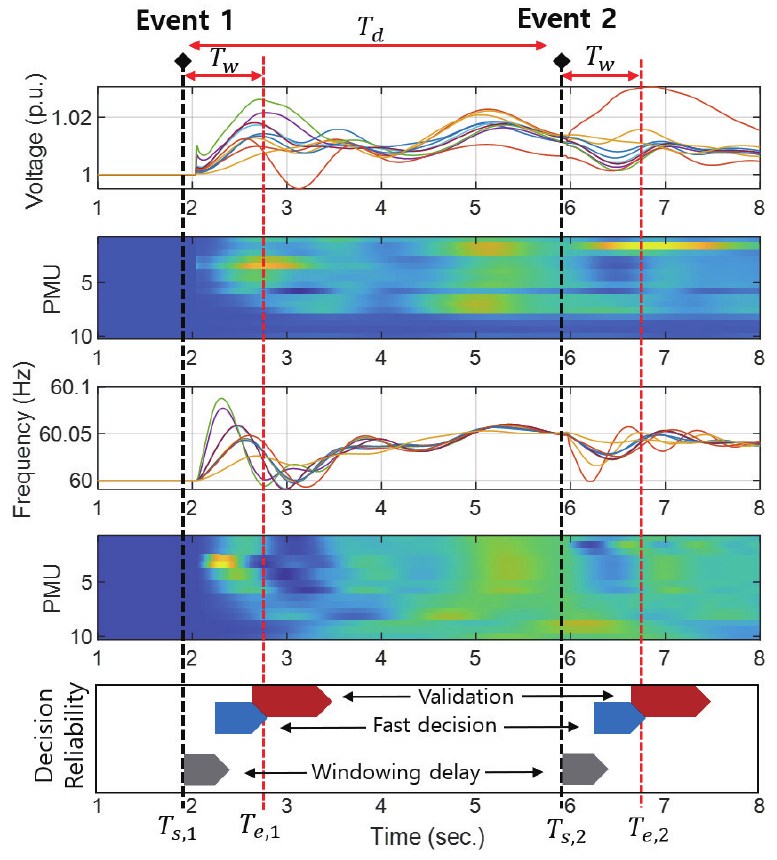
Figure 1. Process of successive event identification composed of 3 time steps: data acquisition, fast decision,